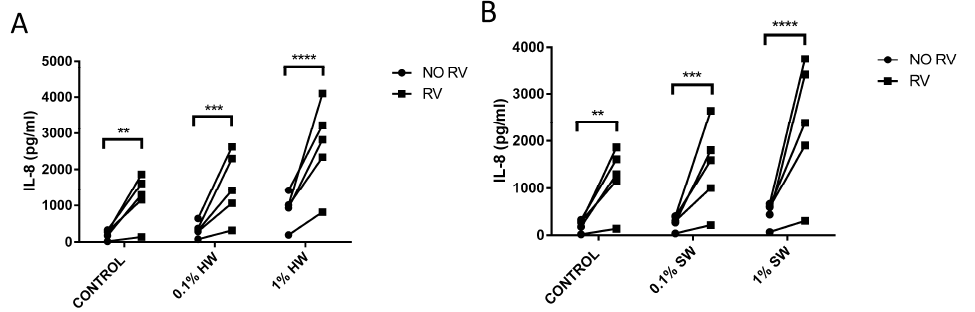
Figure 4. Measurement of IL-8 production from hardwood ( A ) and softwood ( B ) smoke exposure and RV-16 infection. Primary human lung fibroblasts ( n = 5) were stimulated with hardwood and softwood smoke extract at 0.1% and 1% concentration alone, RV-16 infection alone (MOI = 1), or both, and incubated for 24 h. Unstimulated fibroblasts were also measured for IL-8 constitutive release. Supernatants were collected for IL-8 concentration analysis via ELISA. Data expressed as pg/mL. Statistical analysis was executed using two-way ANOVA with Sidak’s post-test. Significance is represented as ** p < 0.01, *** p < 0.001, **** p < 0.0001.